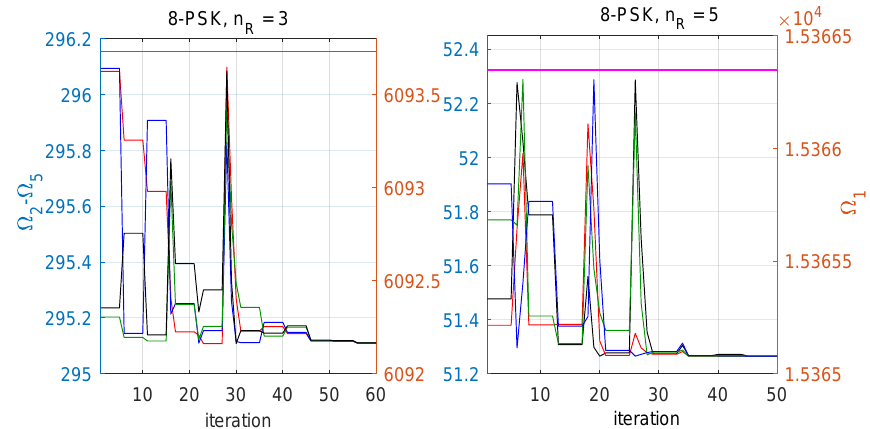
Figure 2. The value of the weighted Ω terms that are affected by the rotation angle (left y-axis) and the value of the rotation-independent Ω 1 (right y-axis) for n R = 3 ( left sub-figure ) and n R = 5 ( right sub-figure ), assuming